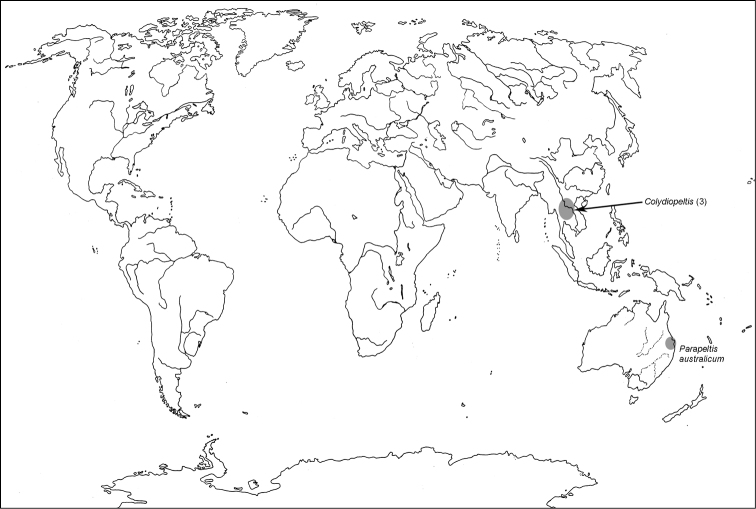
A distribution of the tribe Colydiopeltini.